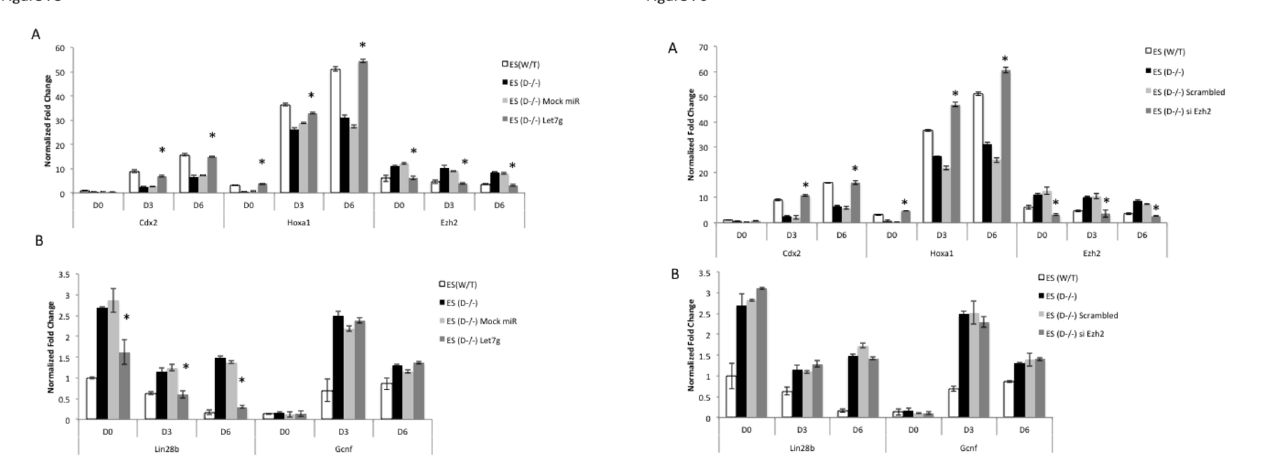
and siRNAs to Ezh2 on patterns of H3K27me3 at Hoxa1 and Cdx2 loci in Dicer -/- ES cells we carried out treatments with let-7g and siEzh2 along with respective controls and chromatin immunoprecipitated genomic DNA from the cell lines using an H3K27me3 specific antibody. A significant reductions of H3K27me3 was found at Hoxa1 and Cdx2 in Dicer -/- ES cells compared to mock and control treated samples (Figure 7A).